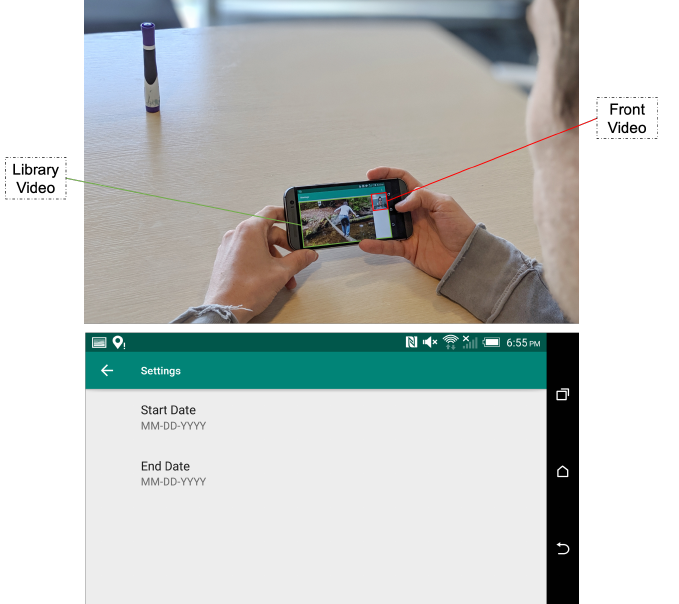
Figure 16. Application 2: photo of the application in use ( up ) and screenshot of the application settings menu ( down